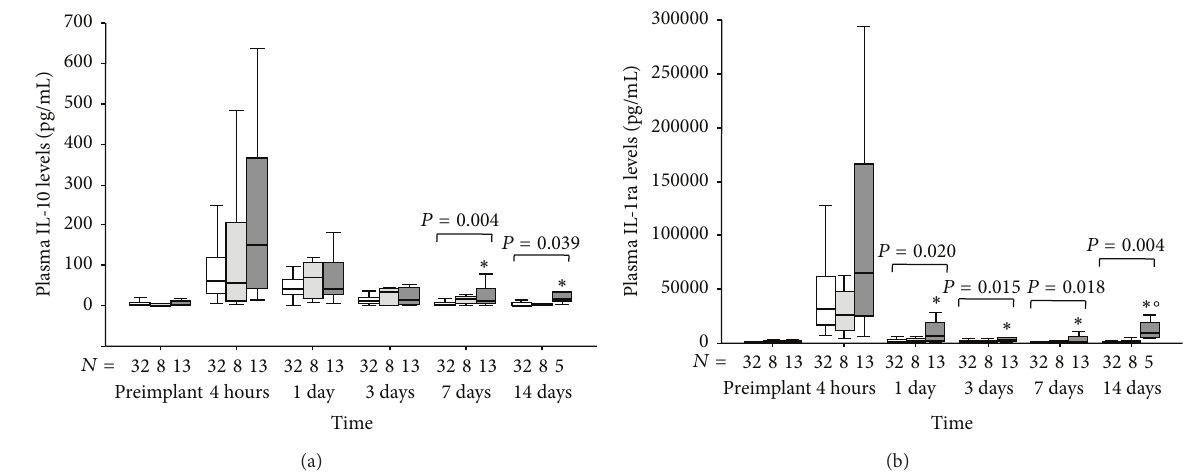
Figure 3: (a) Time course of plasma IL-10 and (b) IL-1ra levels in patients that experienced postoperative maximal tSOFA score < 11 (group A: empty box-plots), and patients with postoperative maximal tSOFA score ≥ 11, with positive (group B: light gray box-plots) or negative (group C: dark gray box-plots) 3-month outcome. 𝑃 values are for differences among groups at each time-point by Kruskall-Wallis text. ∗ 𝑃 < 0.05 versus group A by Mann-Whitney text corrected by Bonferroni. ∘ 𝑃 < 0.05 versus group B by Mann-Whitney text corrected by Bonferroni.